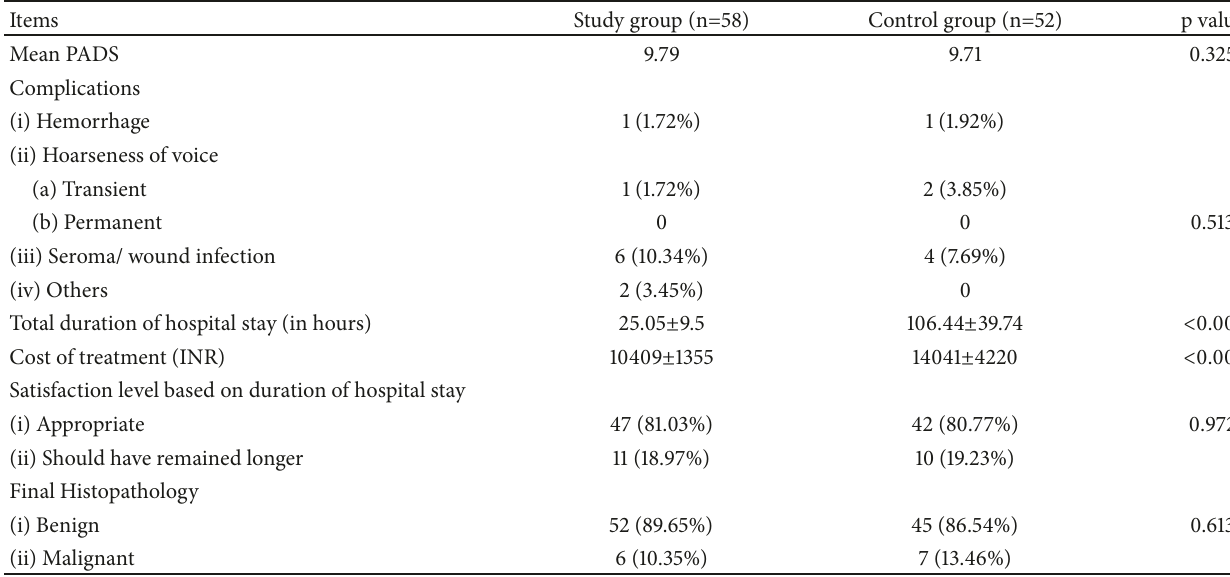
Table 3: Outcome